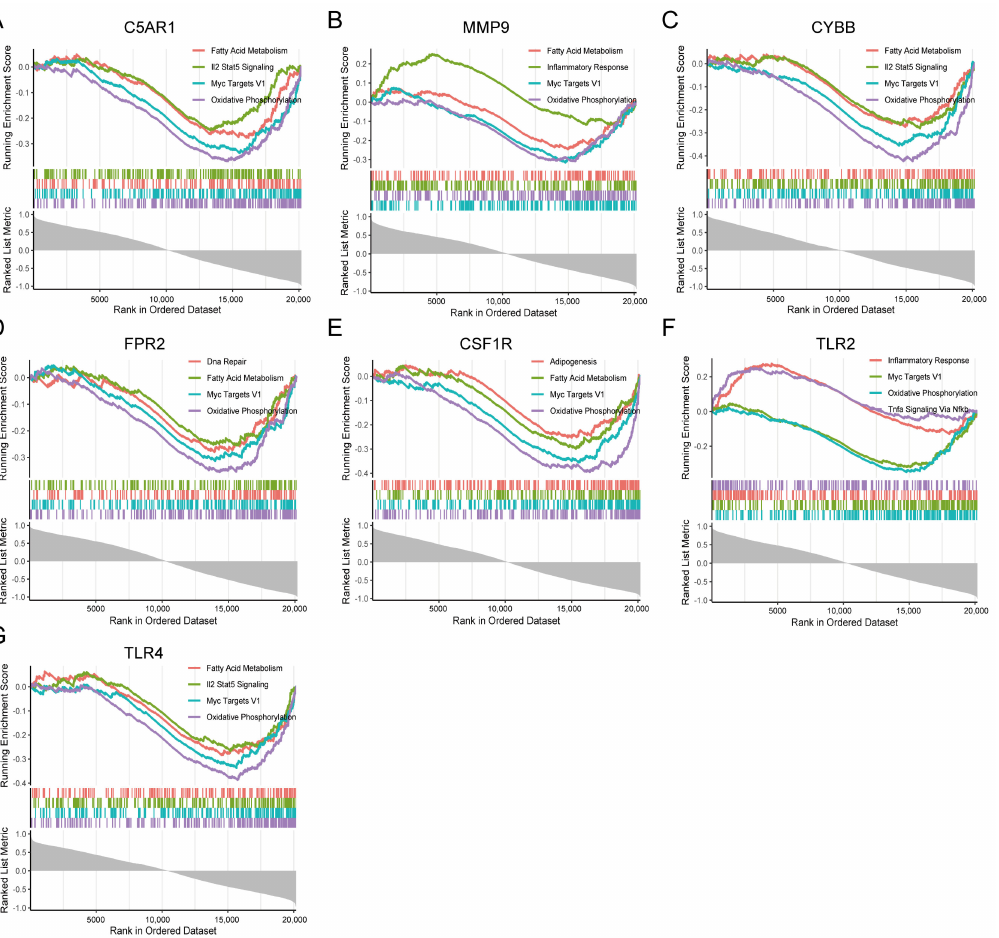
Figure 8. Gene set enrichment plot demonstrates the signaling pathways of the seven-hub immune- related genes involved in COVID-19. ( A ) C5AR1; ( B ) MMP9; ( C ) CYBB; ( D ) FPR2; ( E ) CSF1R; ( F ) TLR2; ( G )